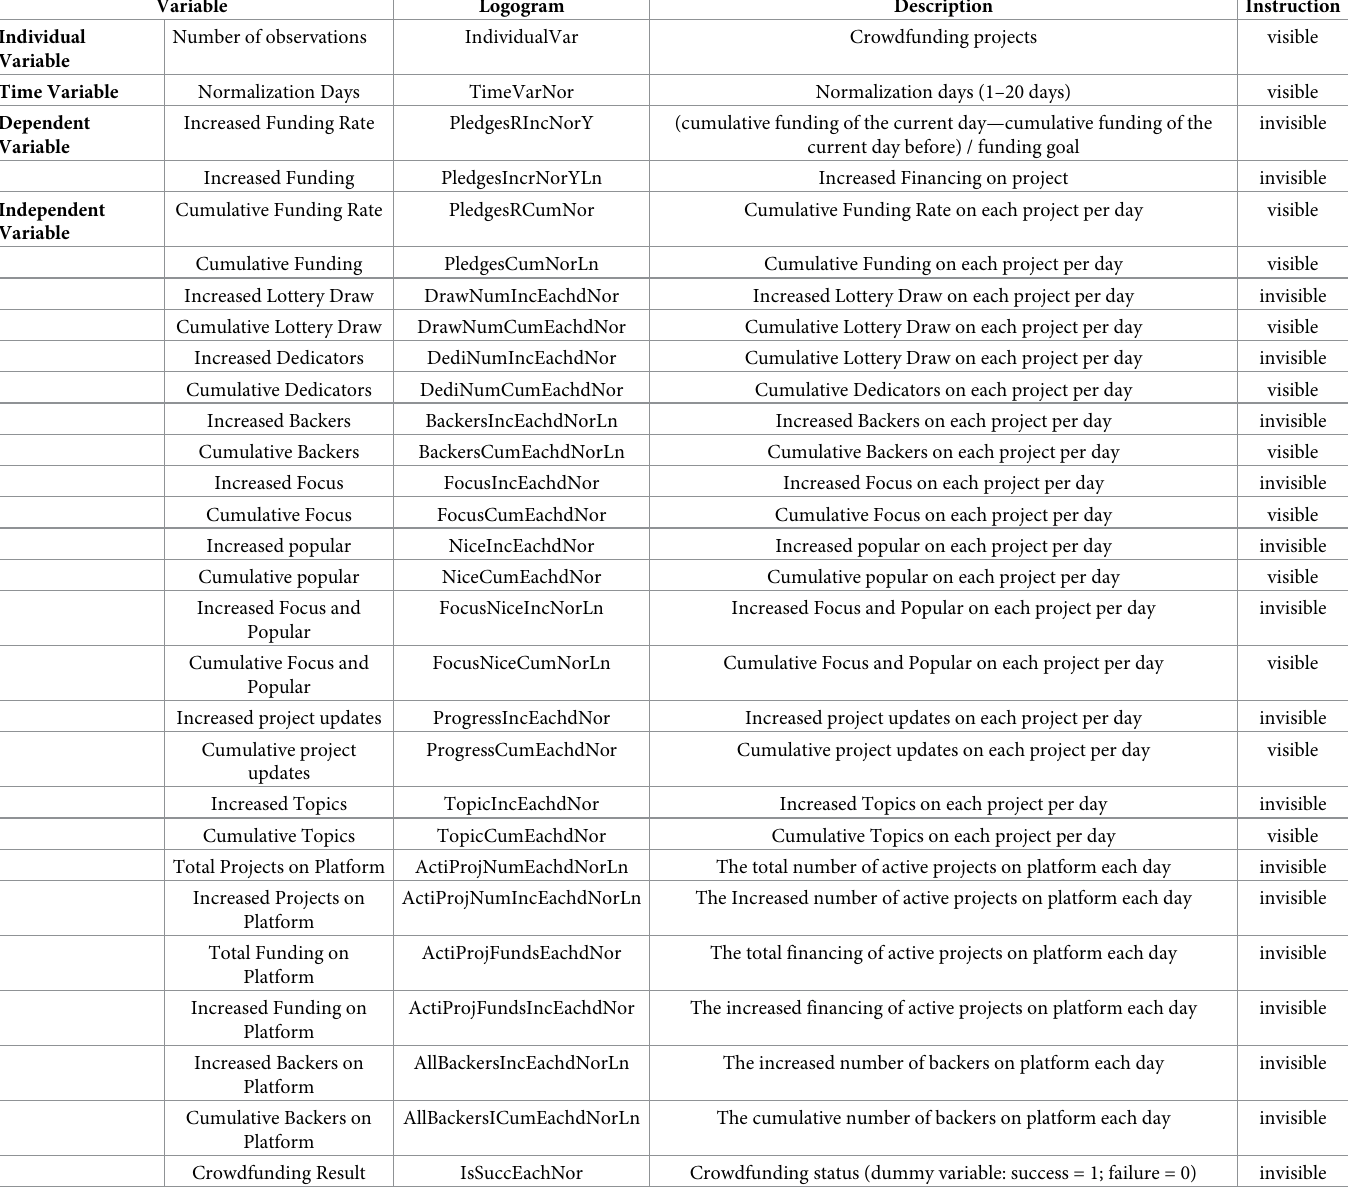
Table 1. Variable definition